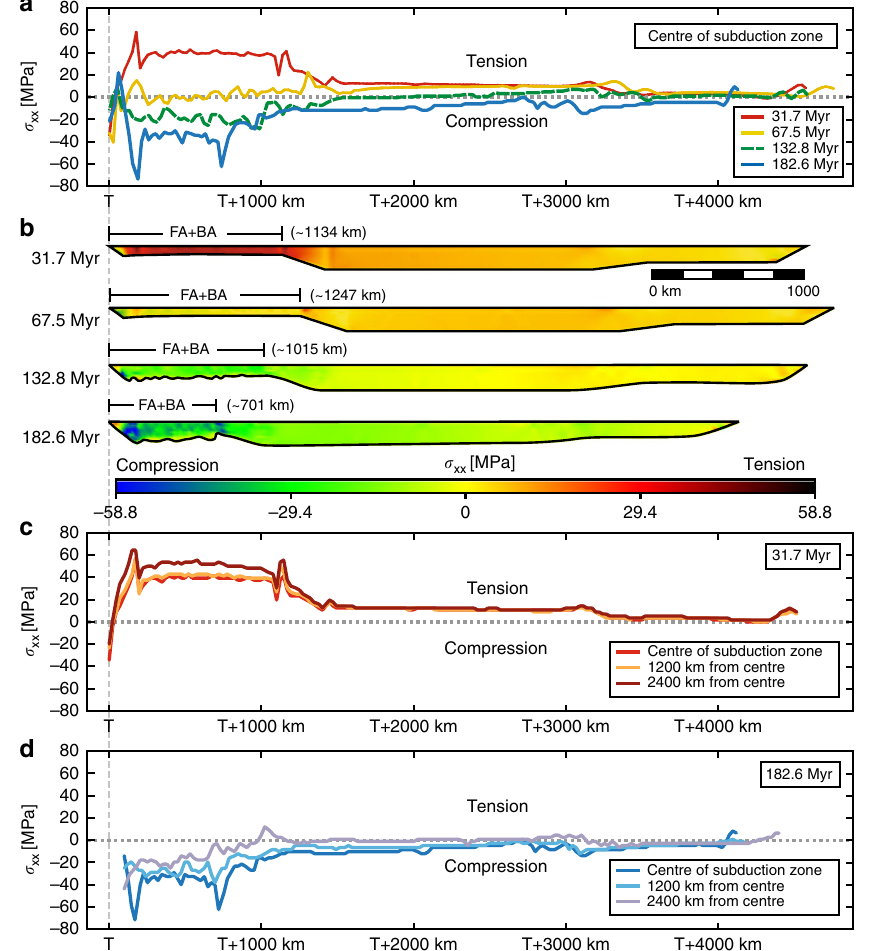
Fig. 7 Model results showing the stresses in the overriding plate. a Trench-normal horizontal deviatoric normal stress ( σ XX ) at the overriding plate surface in the centre of the subduction zone at four different times (31.7 Myr corresponding to the Middle Jurassic in nature, 67.5 Myr corresponding to the Early Cretaceous, 132.8 Myr corresponding to the latest Cretaceous, and 182.6 Myr corresponding to the Late Cenozoic). b Cross-sections showing overriding plate σ XX in the centre of the subduction zone at four different times. c σ XX at the surface at 31.7 Myr (corresponding to the Middle Jurassic) for three locations (in the centre of the subduction zone, at 1200 km from the centre and at 2400 km from the centre, i.e. close to the lateral slab edges). d σ XX at the surface for three locations at 182.6 Myr (corresponding to the Late Cenozoic). Note that T indicates the location of the trench. Also note that the highest tension in c occurs at 2400 km from the centre (i.e. close to the lateral slab edges), while the highest compression in d occurs in the centre of